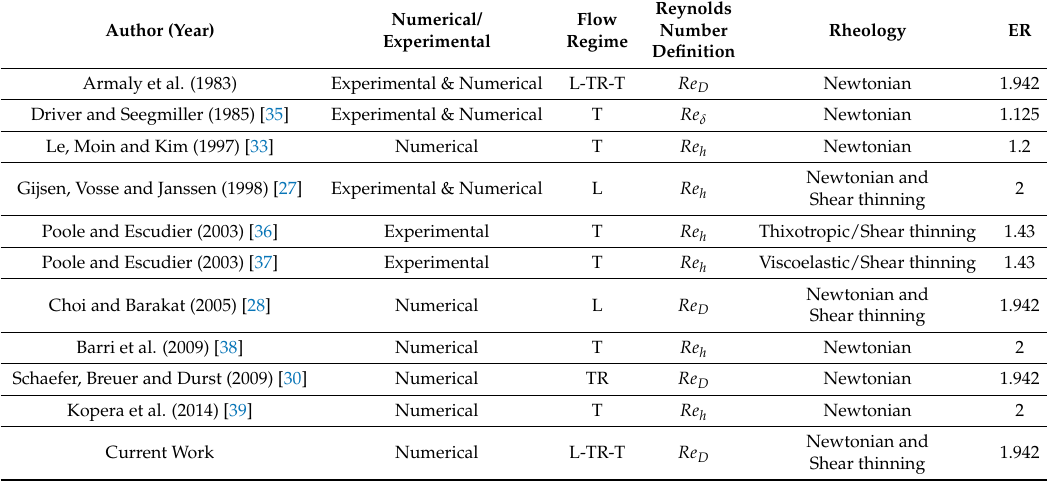
Table 1. Backward facing step flow and reverse flow regions have been explored both experimentally and numerically by a number of authors. The majority of works reported below were a variation on Armaly et al. [29], with the flow regime, rheological properties and expansion ratio (ER) being altered. The following notation is used; L—Laminar, TR—Transitional, T—Turbulent, Re D —Reynolds number based on inlet height, Re δ —Reynolds number based on boundary layer thickness, Re h — Reynolds number based on step